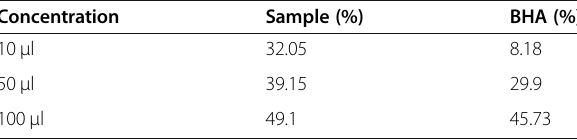
Table 2 Total antioxidant activity of fruit extract of Martynia annua Concentration